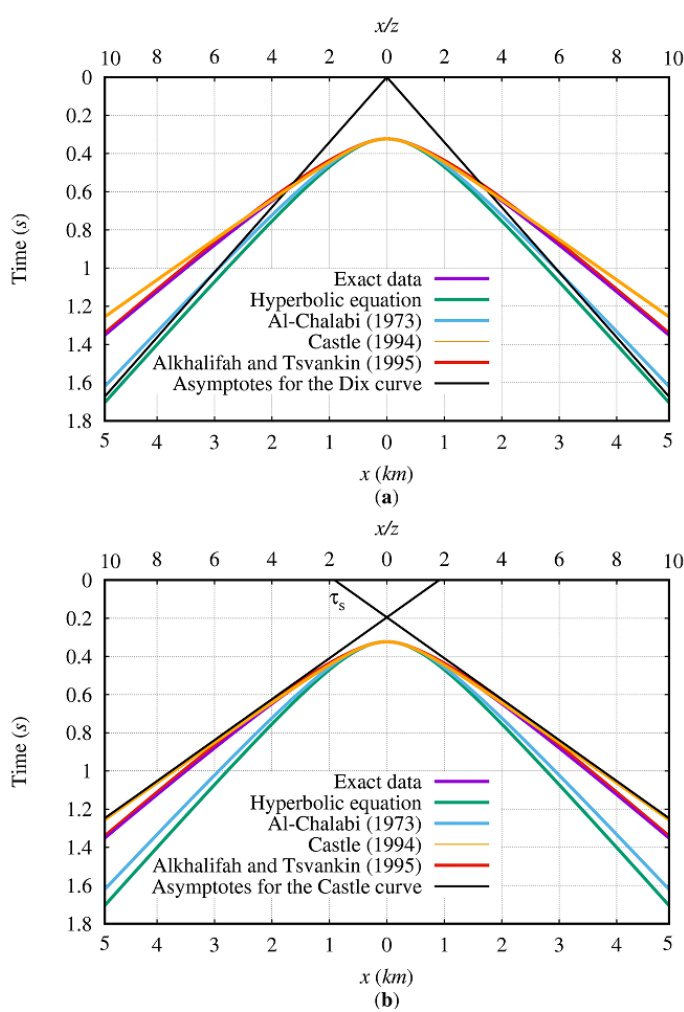
Figure 1. Reflection time for a model with a horizontal reflector at 0.5 km depth, whose incident medium is VTI (Greenhorn). On the horizontal axis, the distance is shown at the bottom of the graphic and the offset depth ratio of the reflector is shown at the top of the graphic. The reflection time is indicated on the vertical axis. The exact reflection time is the purple curve and the conventional hyperbolic approximation (equation (5)) is the green curve. Three non-hyperbolic approximations are also shown: Al- Chalabi (blue curve), Castle (orange curve) and Alkhalifah and Tsvankin (red curve). In (a) the asymptotes of the conventional approach and in (b) Castle’s asymptotes are both shown in